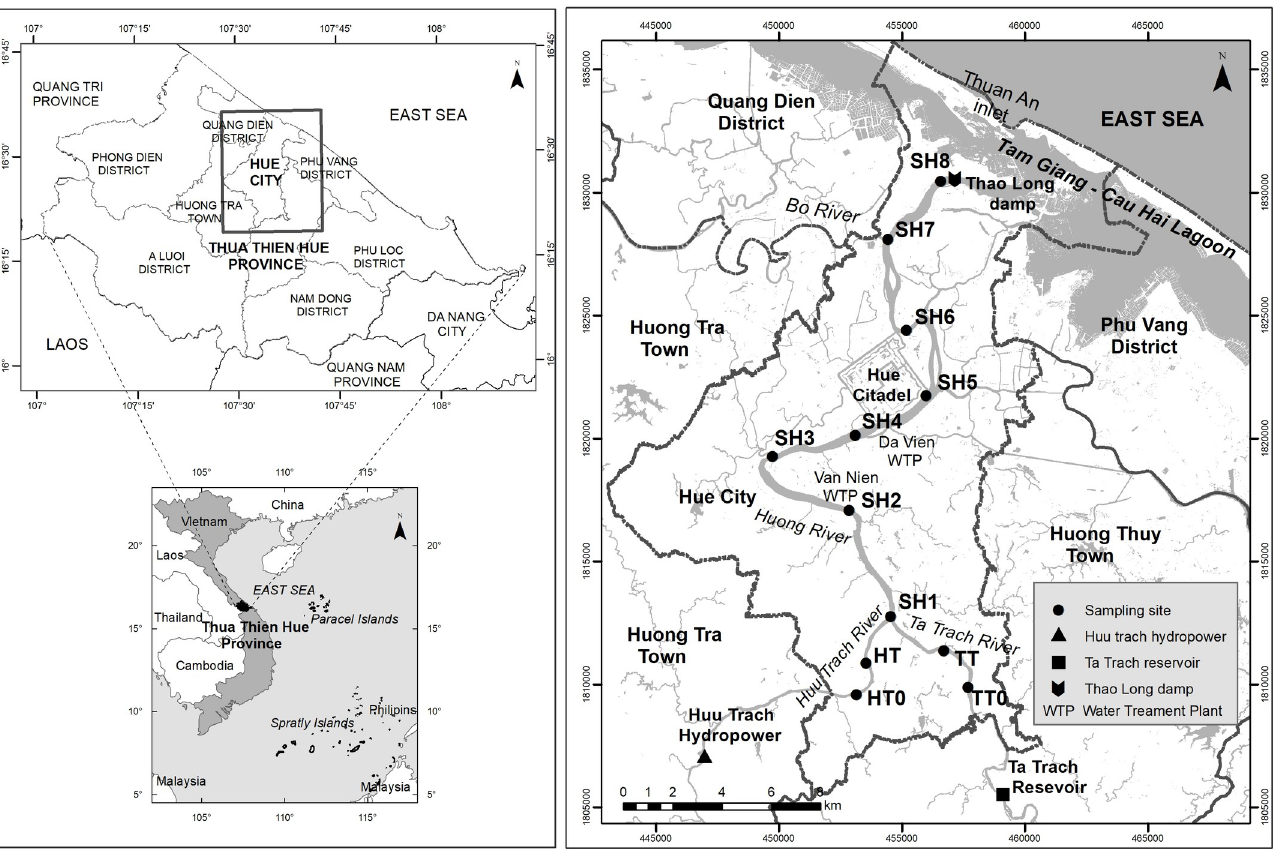
Fig 1. Study area and sampling sites in Huong river. Reprinted from thienhue.gov.vn/geditor.aspx?mapid=10528 under a CC BY license, with permission from Center for monitoring and operating smart cities—Department of Information and Communications—Thua Thien Hue Province, original copyright 2021.